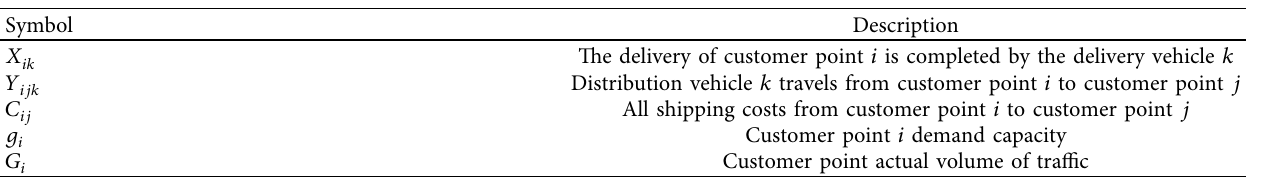
Figure 1: Framework of the proposed action quality Table 1: Symbol definition.